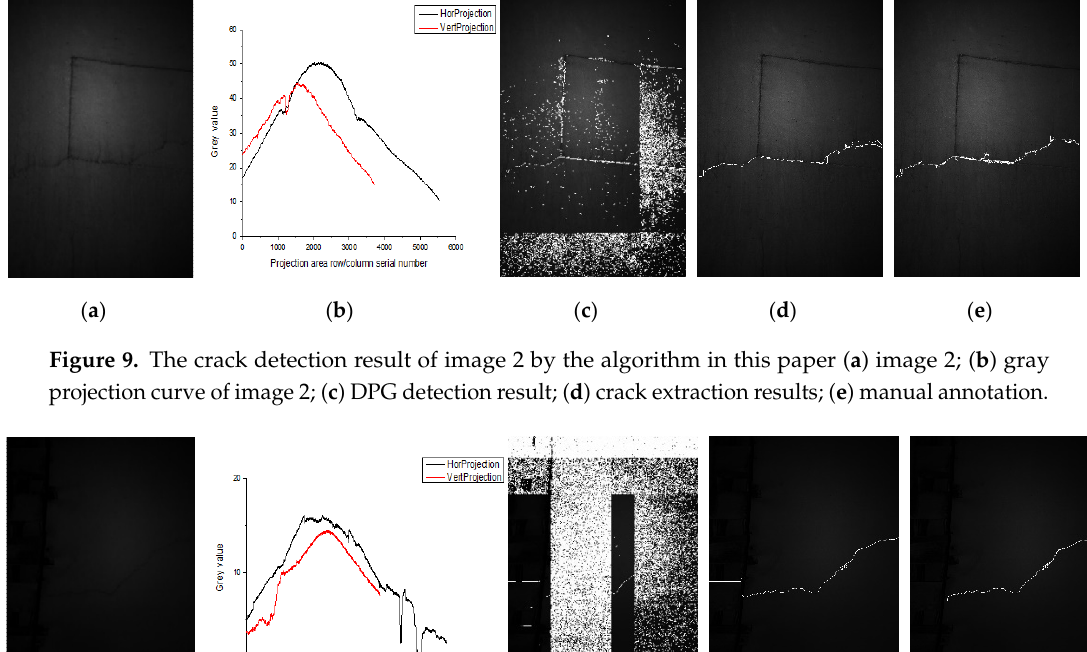
Figure 10. The crack detection result of image 3 by the algorithm in this paper: ( a ) image 3; ( b ) gray